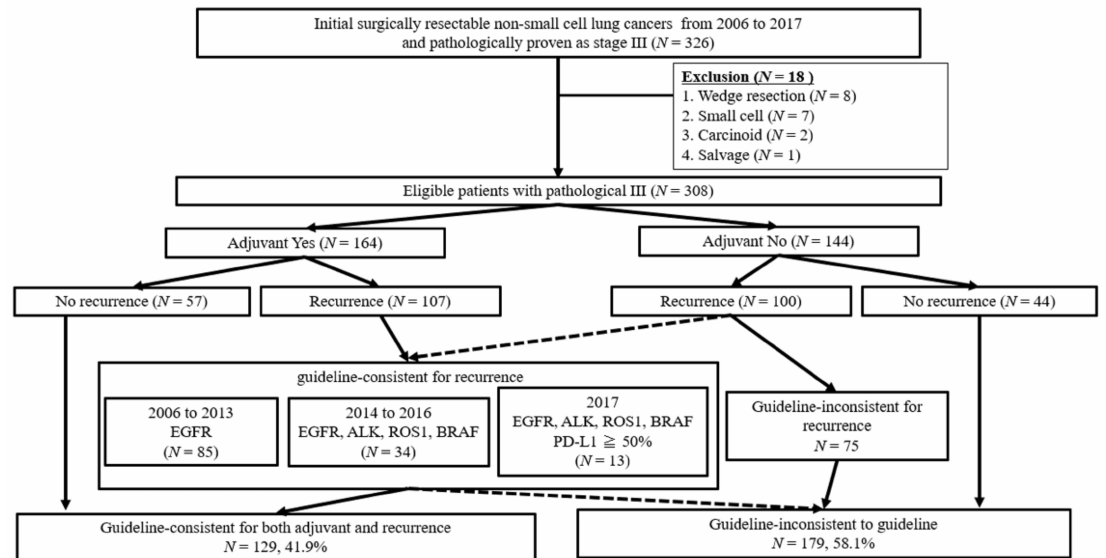
Figure 1. Patient flow diagram.